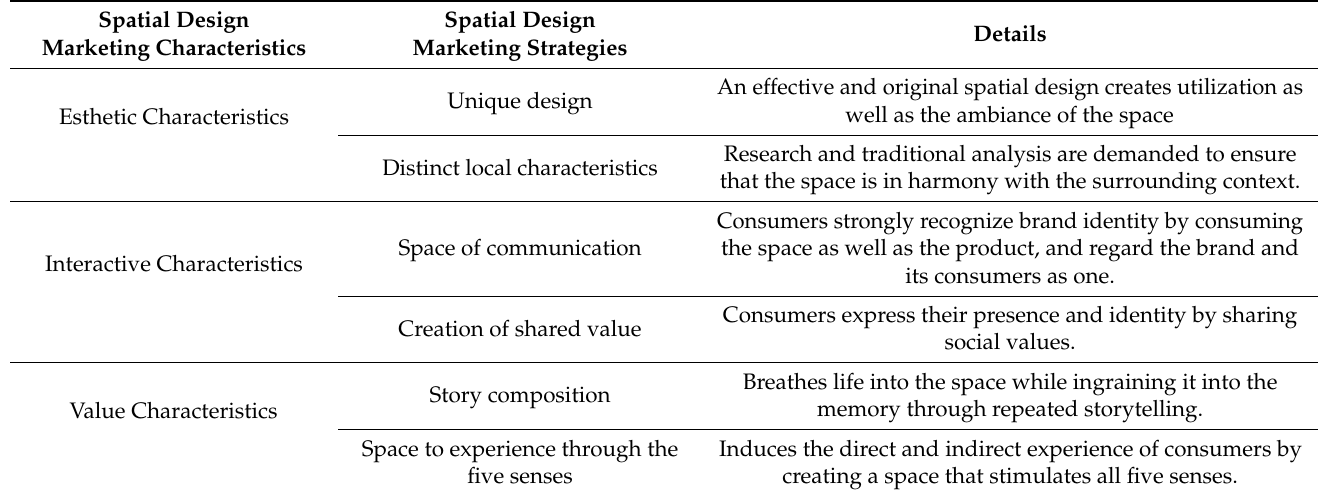
Table 10. Spatial Design Marketing